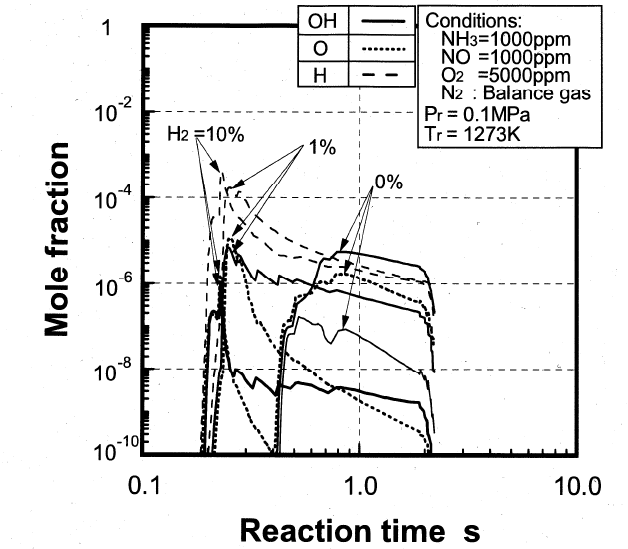
Figure 40. Mole fraction-time profiles of OH, O, H radicals, comparing H 10%, added in the NH is 1273